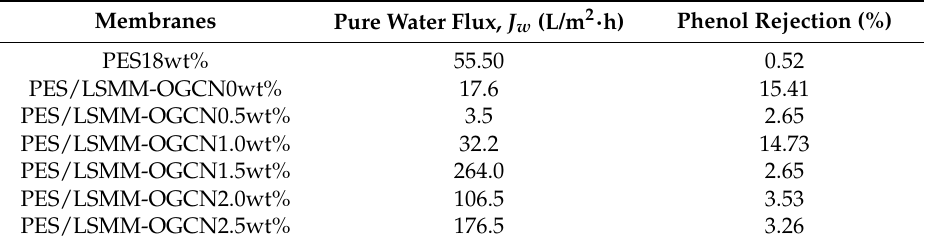
Table 3. Separation performances of PES/LSMM-OGCN membranes prepared at different OGCN loadings.